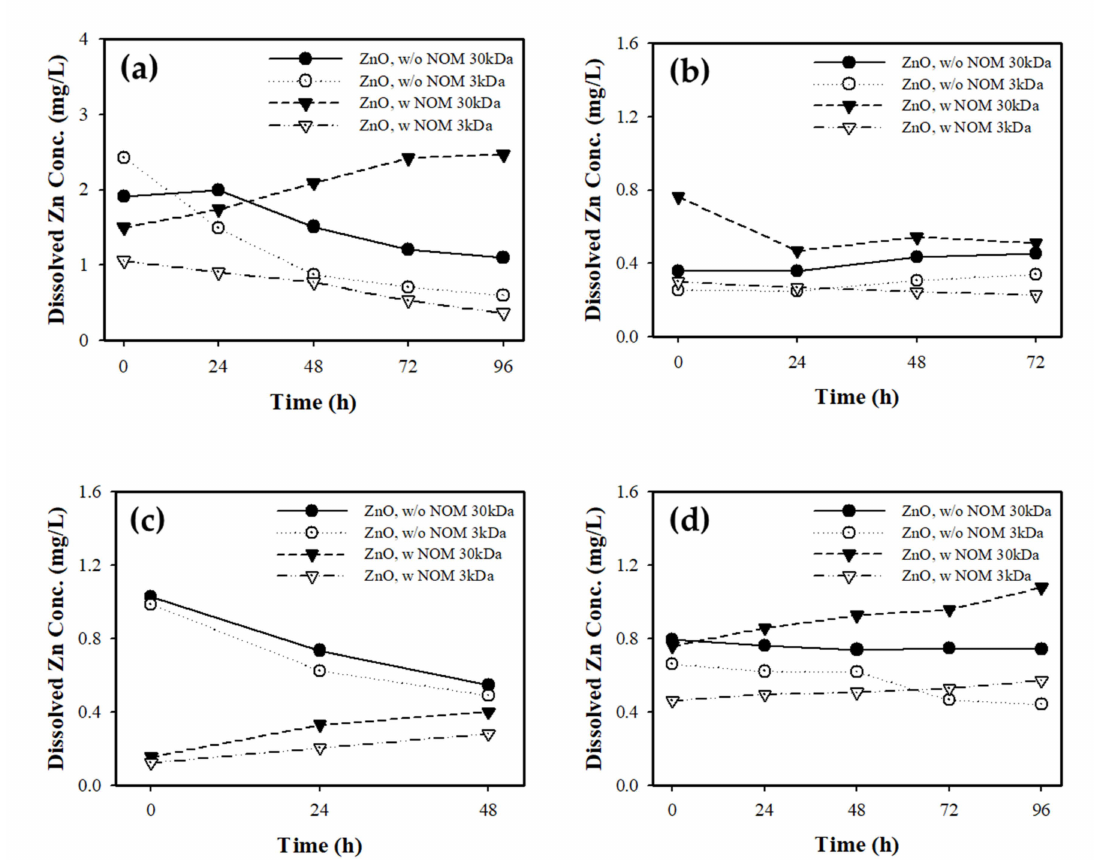
Figure 6. Dissolution of ZnO NPs with / without NOM in DI water ( a ), OECD medium ( b ), ISO medium ( c ), and dechlorinated tap water ( d